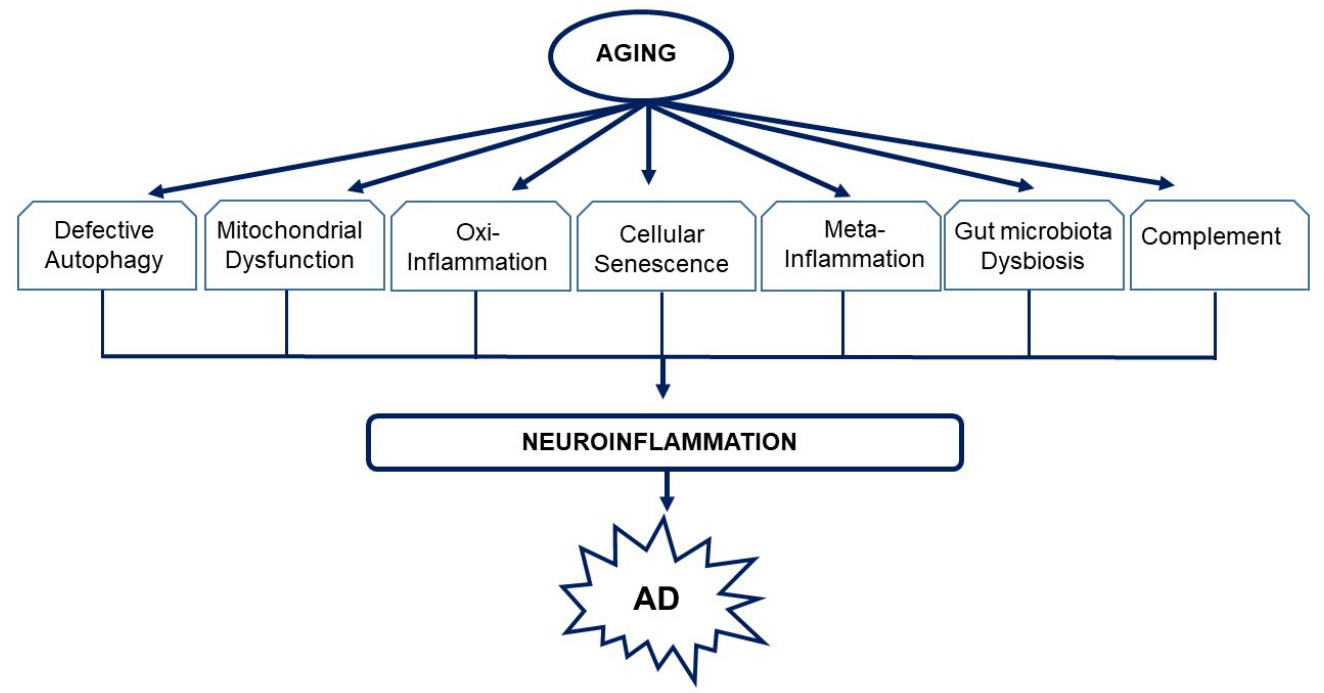
Figure 2. The interactions between aging and neuroinflammation in the pathogenesis of AD. With age, several cellular and molecular mechanisms elicit chronic sterile low-grade inflammation. This interaction of exogenous and endogenous risk stimuli, including defective autophagy, mitochondrial dysfunction, oxi-inflammation, cellular senescence, meta-inflammation, gut microbiota dysbiosis, and complement, triggers neuroinflammation. The resulting inflammatory mediator secreted drives the pathophysiological mechanisms of AD.